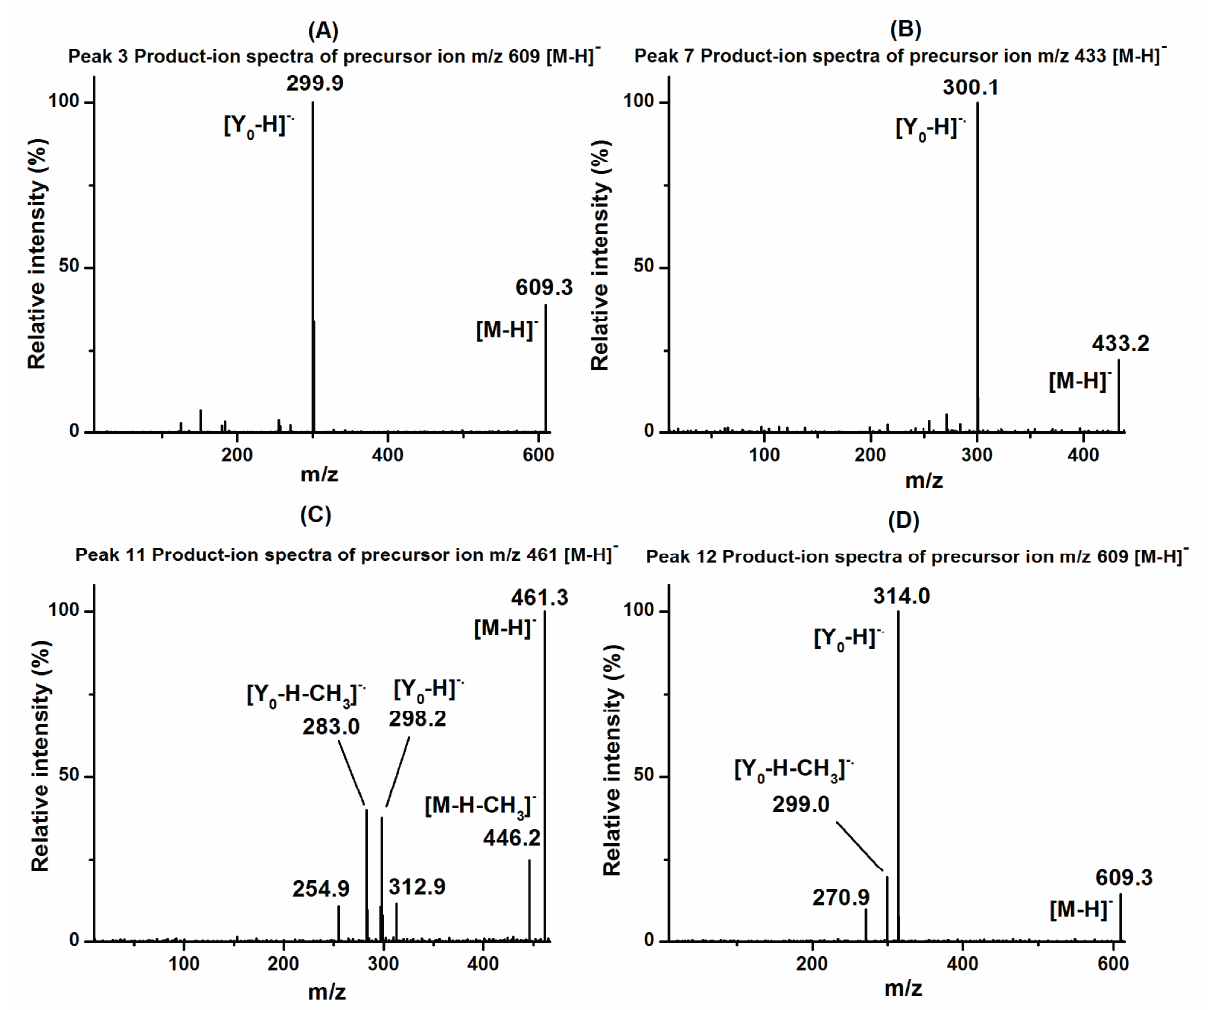
Figure 3. The MS/MS spectra of newly identified flavonoids in fraction II from lotus leaves: ( A ) peak 3; ( B ) peak 7; ( C ) peak 11; ( D ) peak